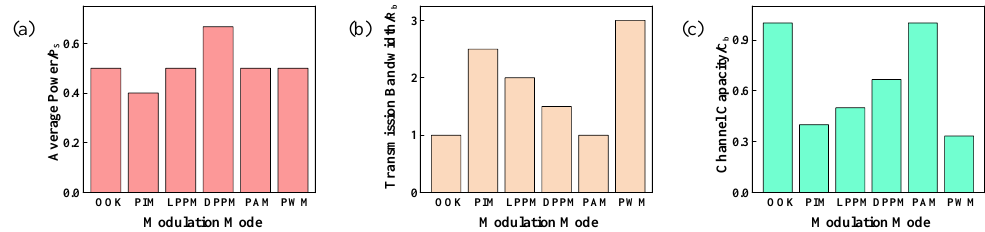
Figure 2. Performance histogram of several optical communication modulation methods when M = 1 [47,48]. ( a ) Average power. ( b ) Transmission bandwidth. ( c ) Channel capacity. Table 1. Performance index of several modulation modes in optical communication.